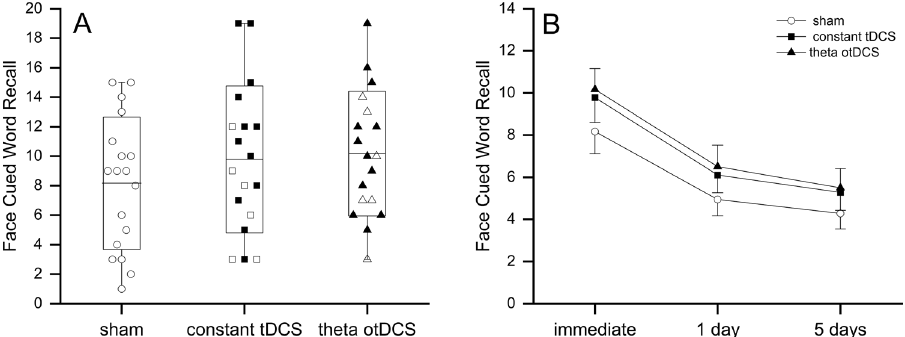
Figure 2. ( A ) The distribution of immediate cued recall across stimulation conditions (box: SD and grand mean line, whisker: range). Colored bullets indicate responders to constant tDCS and theta otDCS in comparison to their sham score. ( B ) The full stimulation × time model (grand mean and